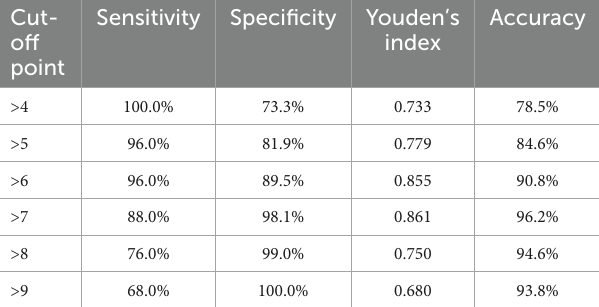
TABLE 4 The diagnostic efficacy of the model at different cut-off